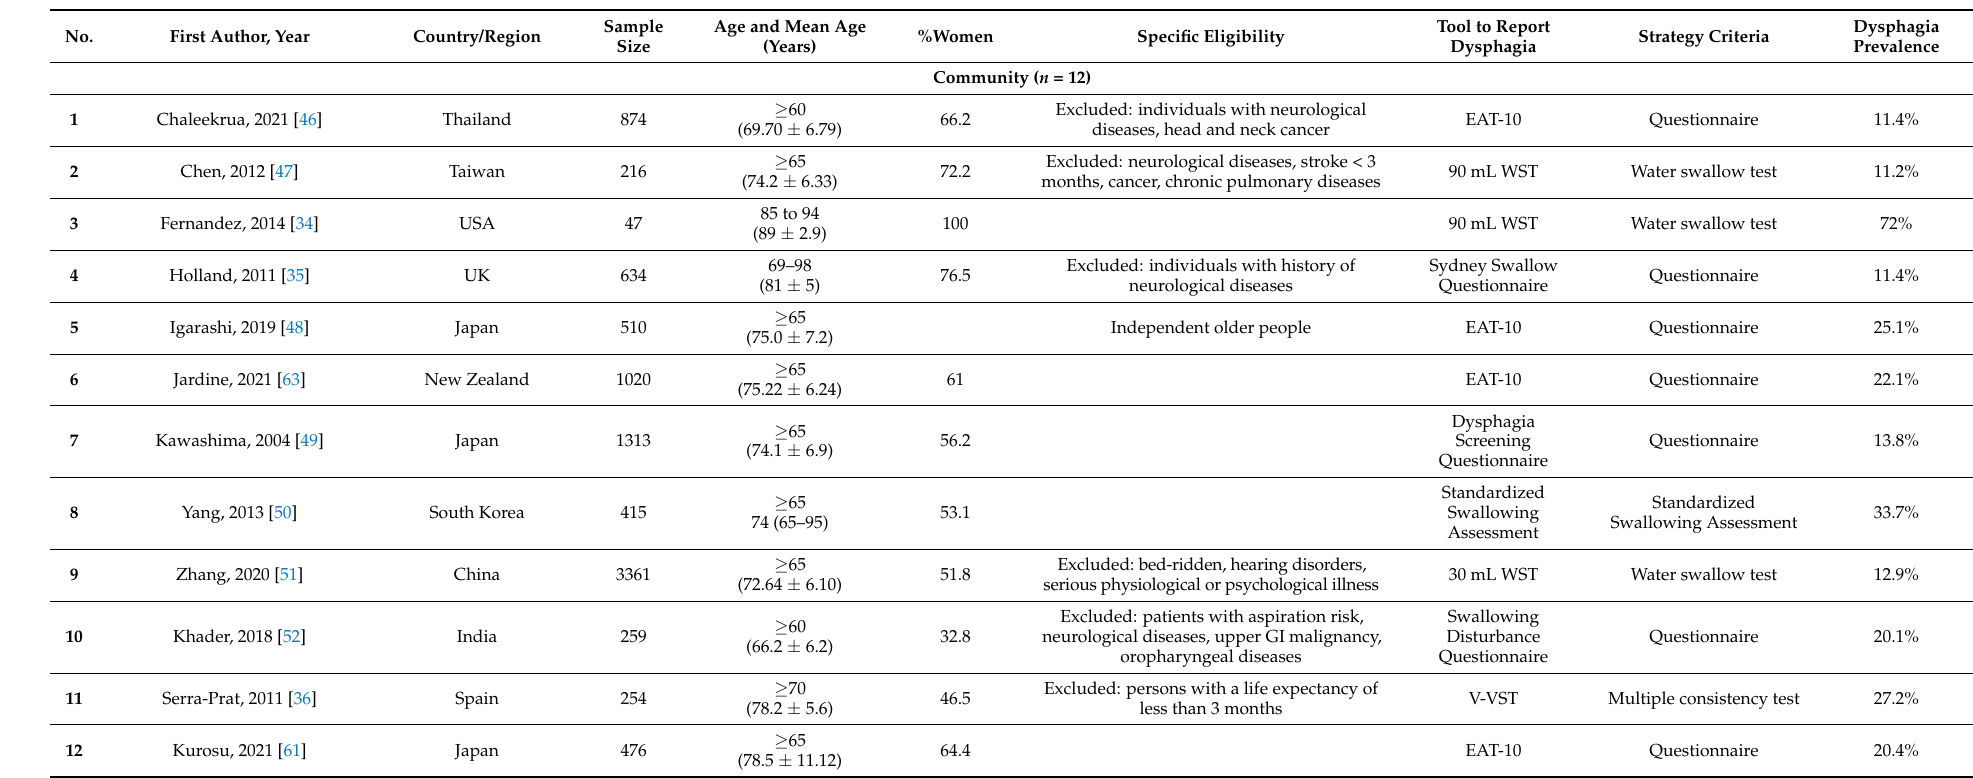
Table 1. Characteristics of included studies ( n =